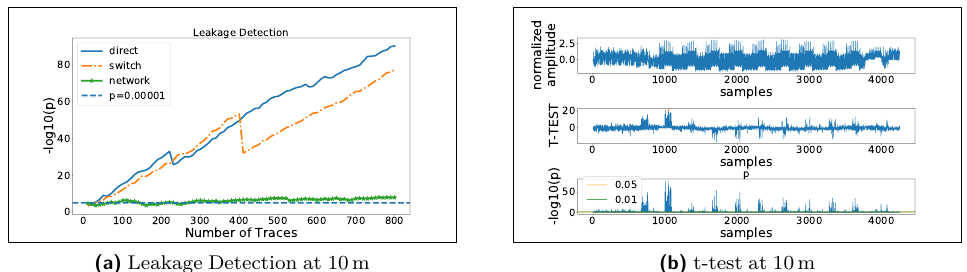
Figure 17: At 10 m we can easily detect the leak with all types of connections (a). The t-test has peaks for all data-dependent points, including the output of the Sbox, which can be used to attack